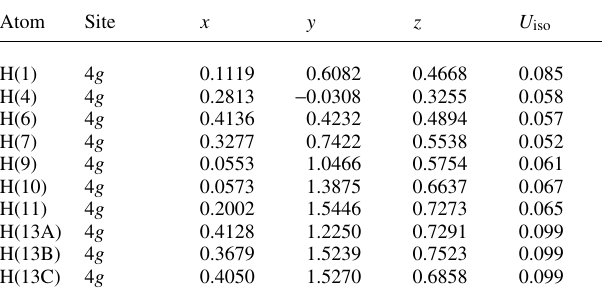
Table 2. Atomic coordinates and displacement parameters (in Å 2 ) .